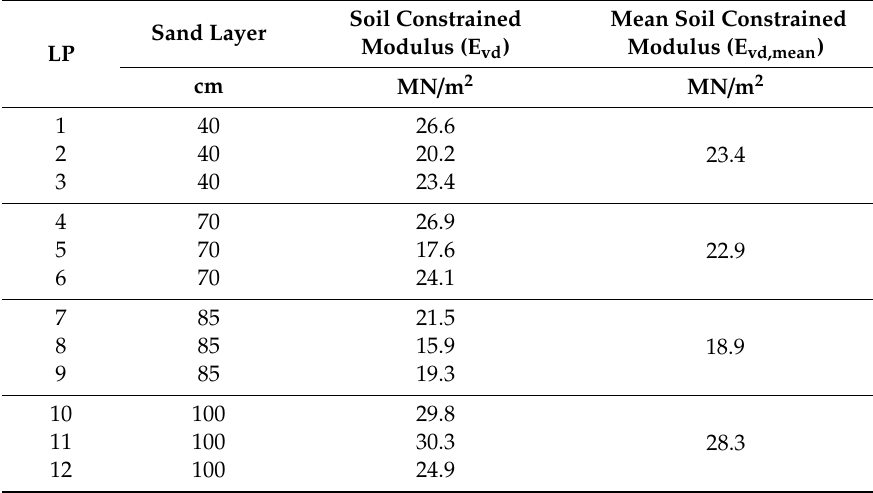
Figure 2. The cylinder and dynamic plate used for the control of sand compaction. Table 2. Results of ZORN dynamic plate tests, accuracy 0.1 MN/m 2 .